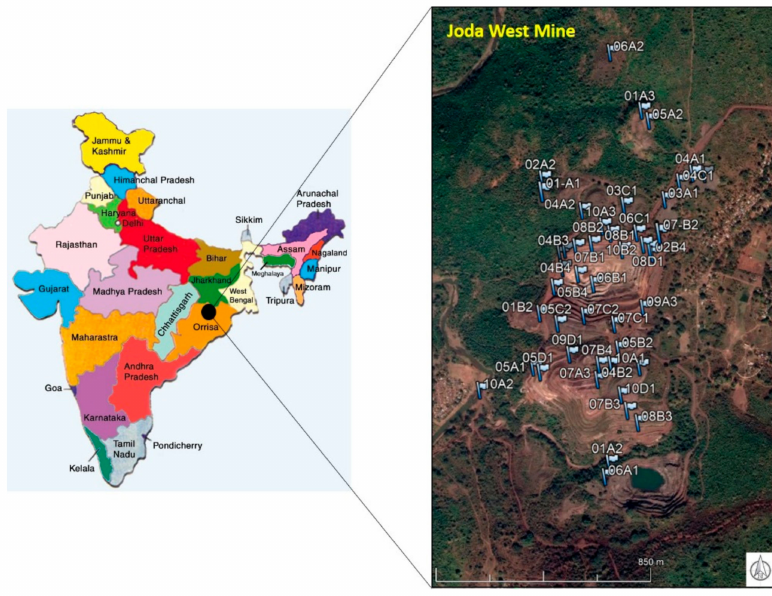
Figure 1. Study area with location and codes of sampled rock wastes at Joda West Iron and Manganese